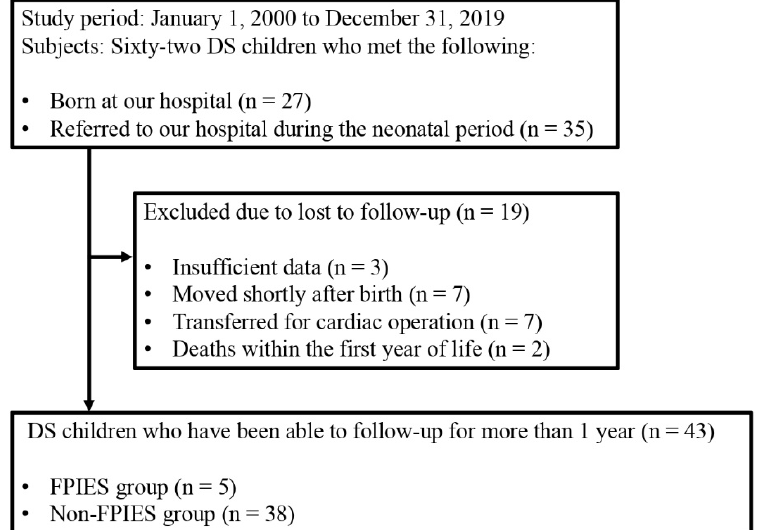
Figure 1. Flow diagram of the subject selection process. DS, Down syndrome; FPIES, food protein- induced enterocolitis syndrome